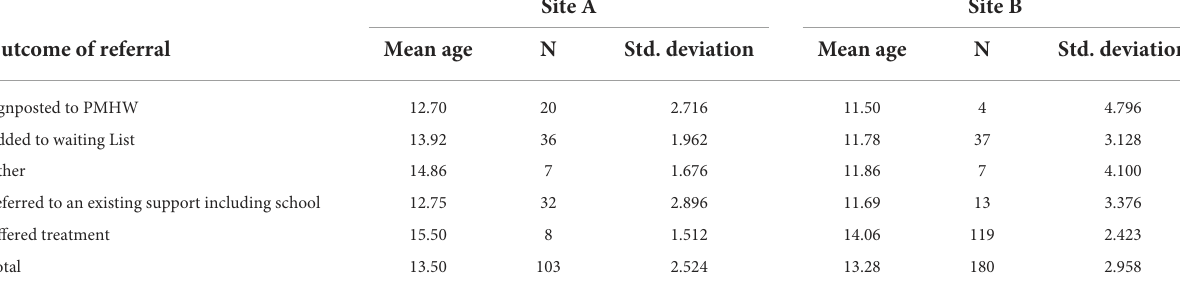
TABLE 2 Age & referral outcome (Site A &